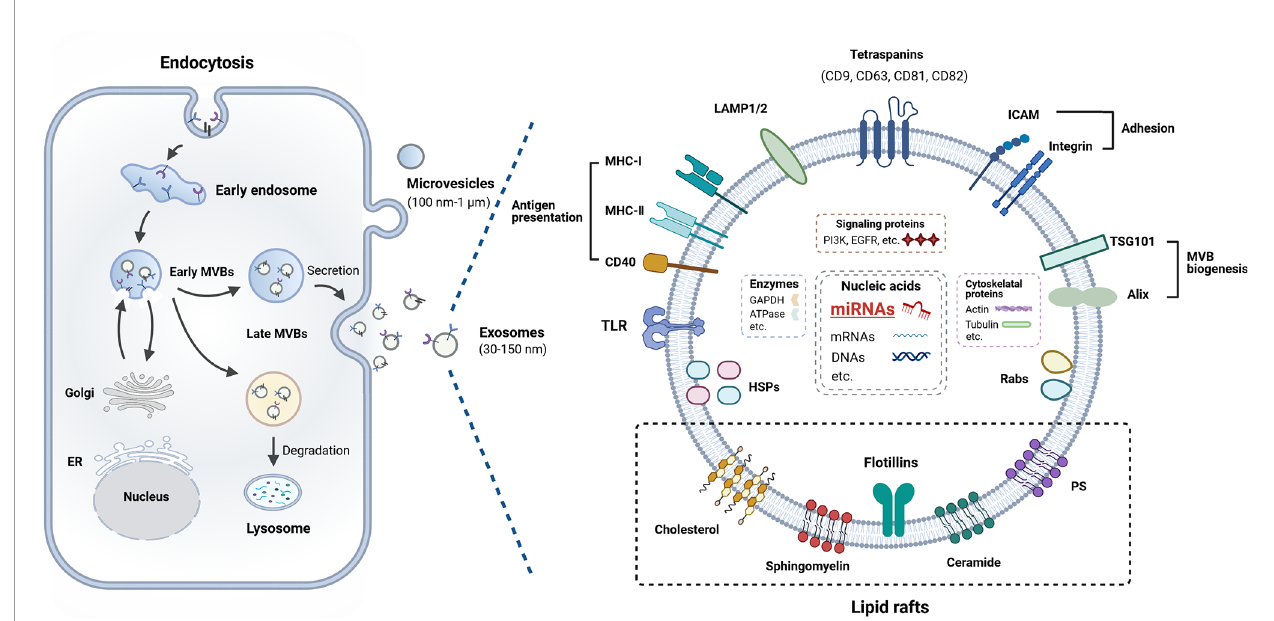
FIGURE 1 | Biogenesis and composition of exosome. Exosomes are derived from endosomes that formed from cellular membrane compartments. The endosomes harboring intraluminal vesicles (ILVs) are called multivesicular bodies (MVBs). During this process, early endosomes (EEs) communicate with the Golgi apparatus through bidirectional vesicle exchange. MVBs may be degraded by lysosomes or fuse with the plasma membrane, and then release ILVs into extracellular space termed as exosomes. Exosomes contain a range of proteins, miRNAs, mRNAs, and DNA molecular cargo. Details are provided in the main